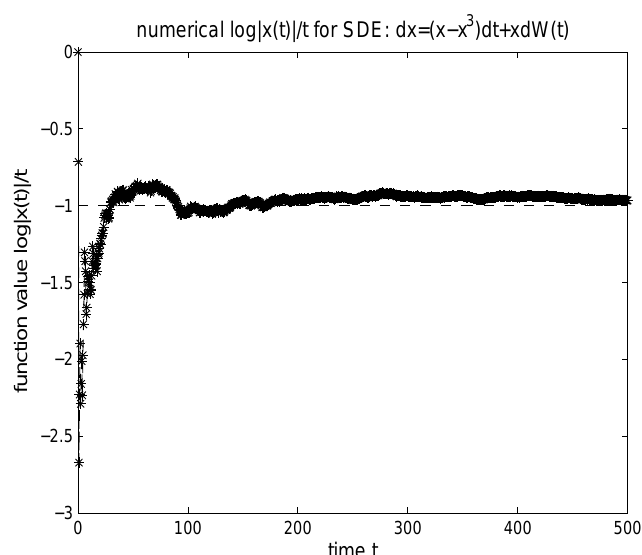
Figure 8. Numerical simulation of log | x ( t ) | / t for the stochastic differential equation: dx = ( x − x 3 ) dt + xdW ( t ) . The time interval: [0,500], the stepsize: dt = 0.5, the initial value X ( 0 ) =